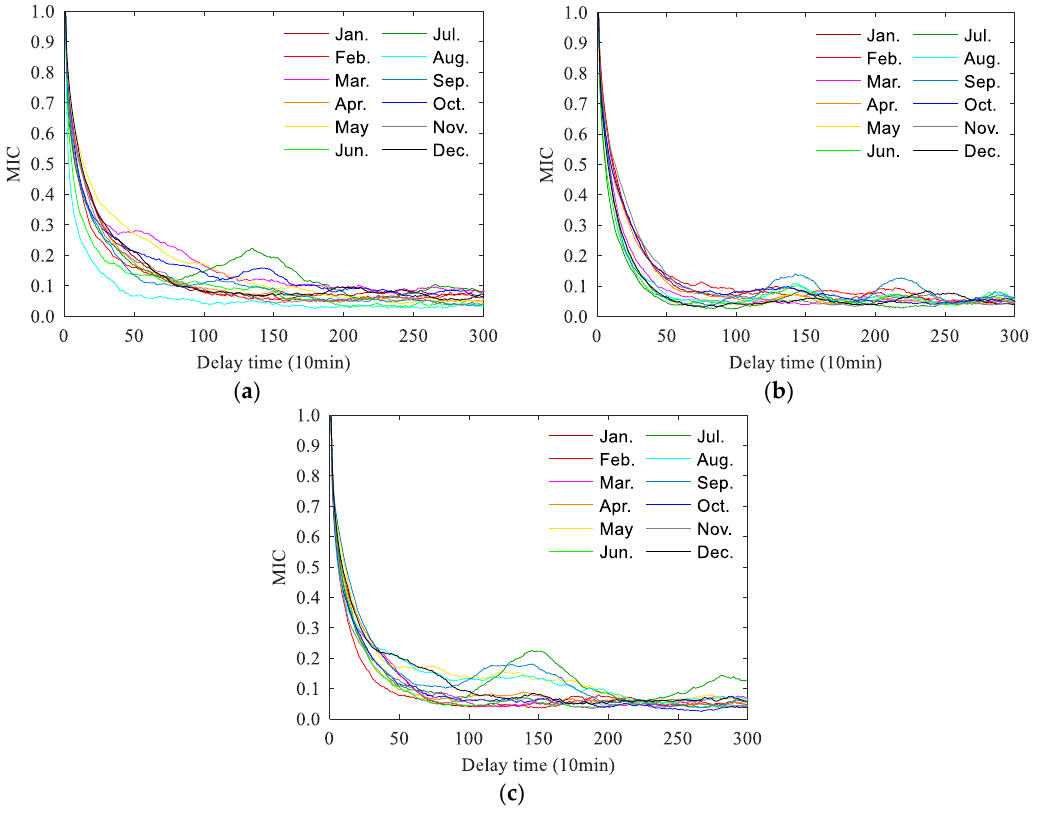
Figure 4. The variation law of the MIC with the delay time: ( a ) wind speed series of anemometer tower 1; ( b ) wind speed series of anemometer tower 2; ( c ) wind speed series of anemometer tower 3.